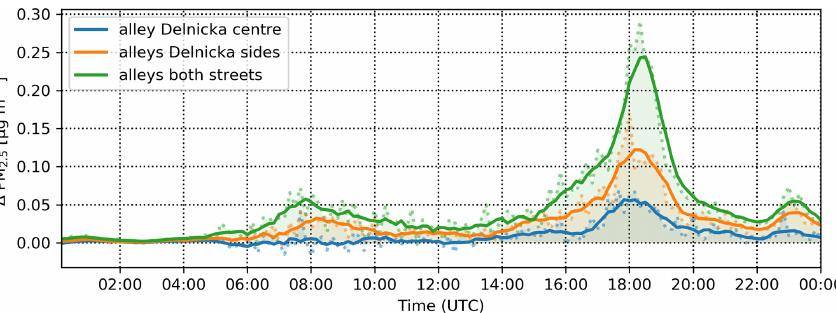
Figure 12. Domain-averaged differences in PM 2 . 5 for new-tree-alley scenarios SB13 (blue), SB14 (orange) and SB15 (green). Dotted lines: 10min values; solid lines: 1h moving average.